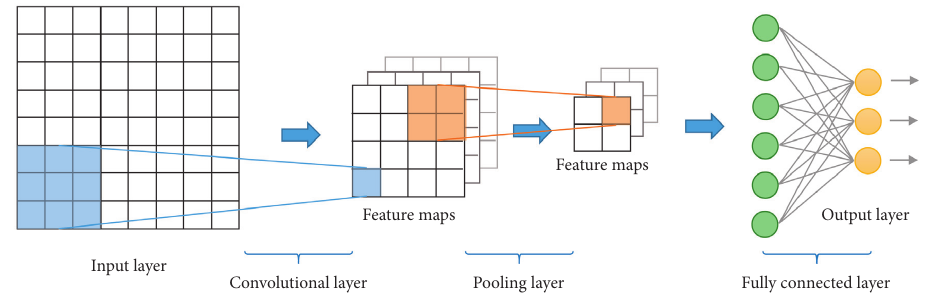
Figure 1: CNN architecture for image